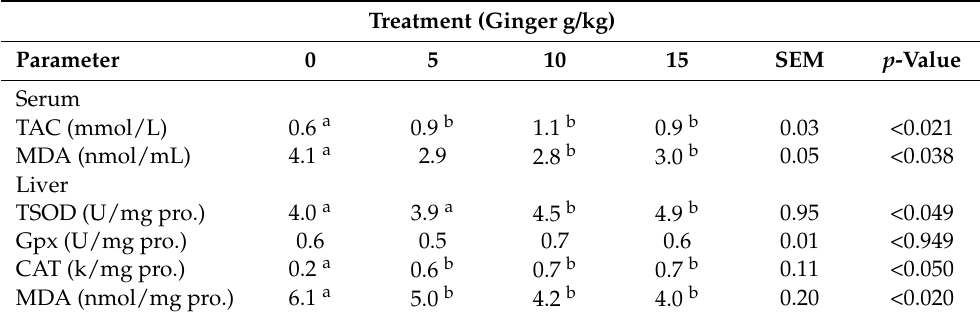
Table 4. Antioxidant parameters in serum and livers of broiler chickens fed various concentrations of ginger